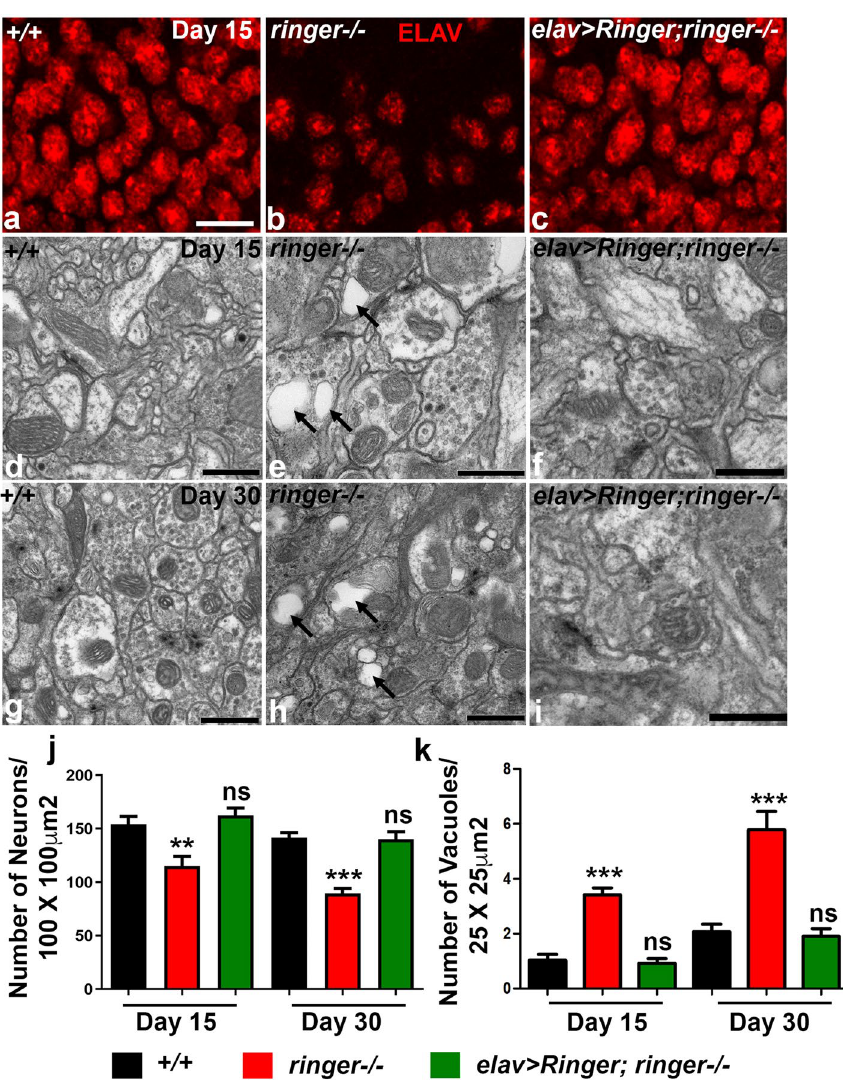
Figure 2. Ringer mutants show phenotypes consistent with neurodegeneration. ( a - c ) Confocal images of day 15 adult Drosophila of wild type ( a ), ringer mutant ( b ) and elav > Ringer;ringer −/− rescue ( c ) brains stained with anti-ELAV (red). ( d - i ) TEM images of day 15 ( d - f ) and day 30 flies ( g - i ) of wild type ( d , g ), ringer −/− ( e , h ) and ringer rescue ( f , i ) . ( j ) Quantification reveals a progressive decrease in number of neurons per 100 μm 2 area from mushroom body regions of adult brains of day 15 and day 30 ringer −/− (red) compared to wild type (black) and ringer rescue flies (green). n = 7 brains per genotype. Statistics was done using one-way Anova with Tukey’s multiple comparison test, day 15 ringer −/− ** p = 0.0015, ringer rescue ns p = 0.7018, day 30 ringer −/− *** p = 0.0008, ringer rescue ns p = 0.3964. ( k ) Increased number of vacuoles in neurons of day 15 and day 30 ringer −/− (red) compared to wild type (black) and ringer rescue flies (green). n = 6 brains per genotype. Statistics was done using one-way Anova with Tukey’s multiple comparison test, day 15 ringer −/− *** p < 0.0001, ringer rescue ns p = 0.6763, day 30 ringer −/− *** p < 0.0001, ringer rescue ns p = 0.6825. Scale bars: ( a - c ) = 5 µm, ( d - f , i ) = 600 nm and ( g , h ) = 800